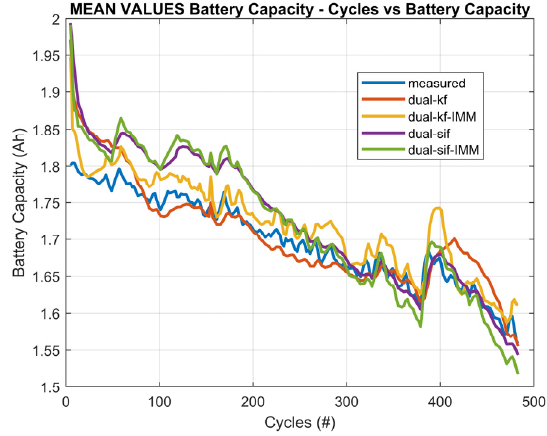
Figure 12. Battery capacity estimation results of each algorithm.